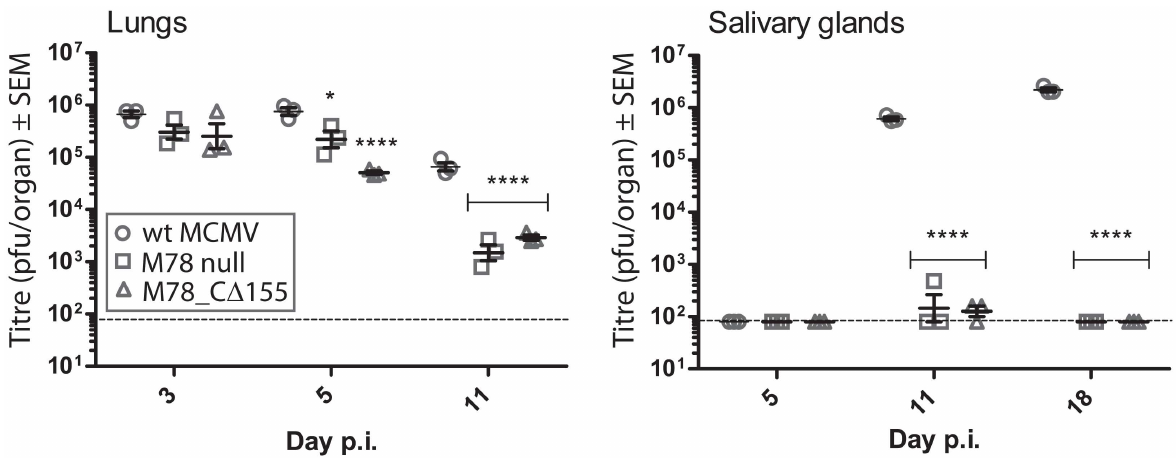
Fig 6. Effects of M78 mutation upon replication in vivo . Mice were infected intranasallyunder anaesthesia and organs harvested at different days post-infection. Infectious virus titres recovered from lungs and salivary glands are shown as individualdata points (n = 3 mice per group) with the mean and standard error of the mean indicatedby bars. Asterisks indicate statistical significance comparingwt with the mutant viruses (2-way ANOVA with Bonferroni post-test): * P < 0.05; **** P <